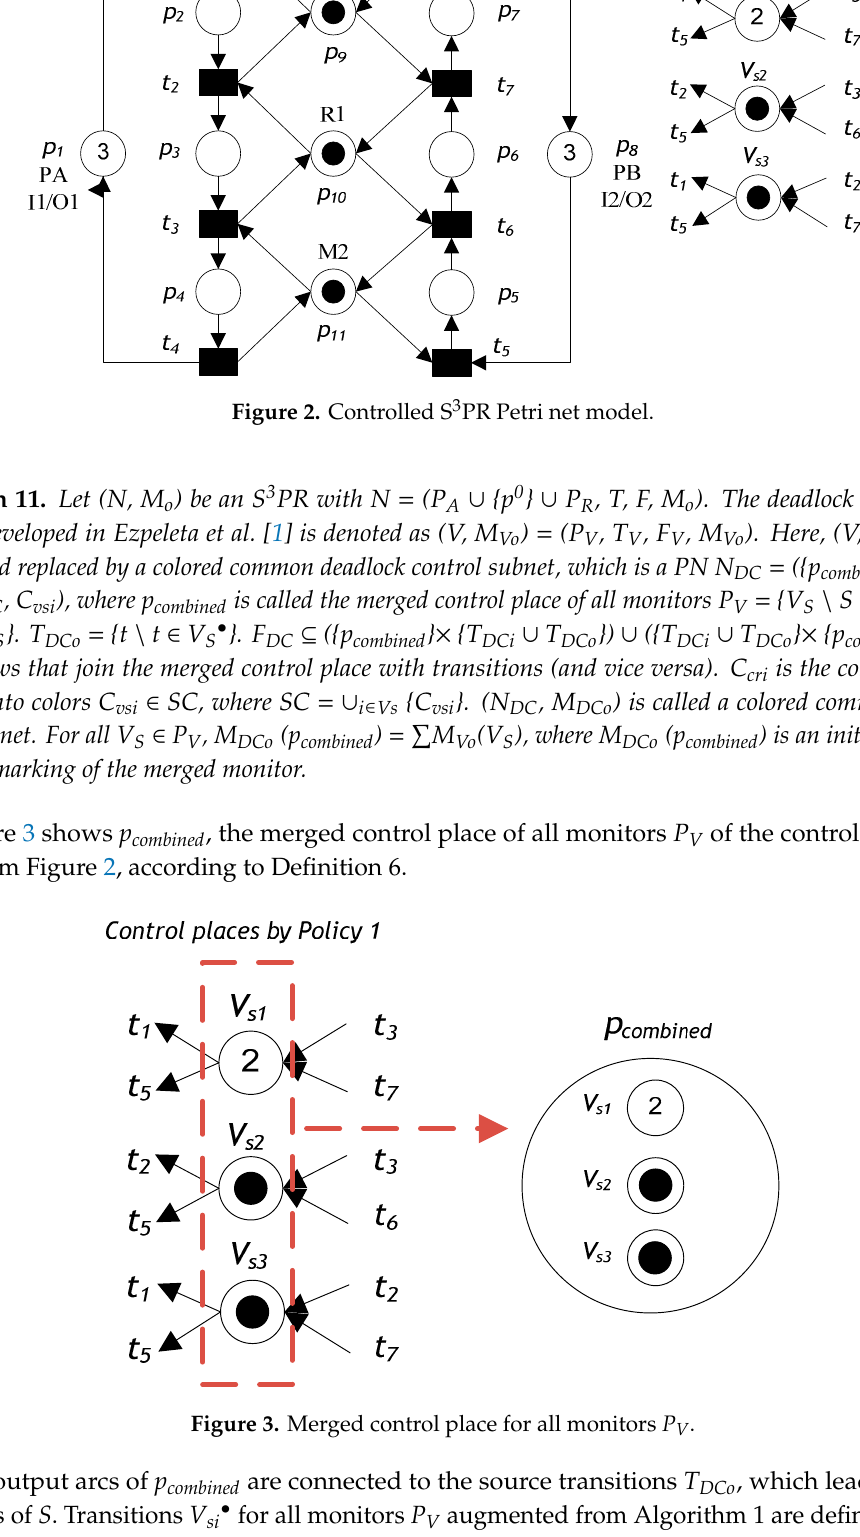
Figure 1. S 3 PR Petri net model of an AMS.